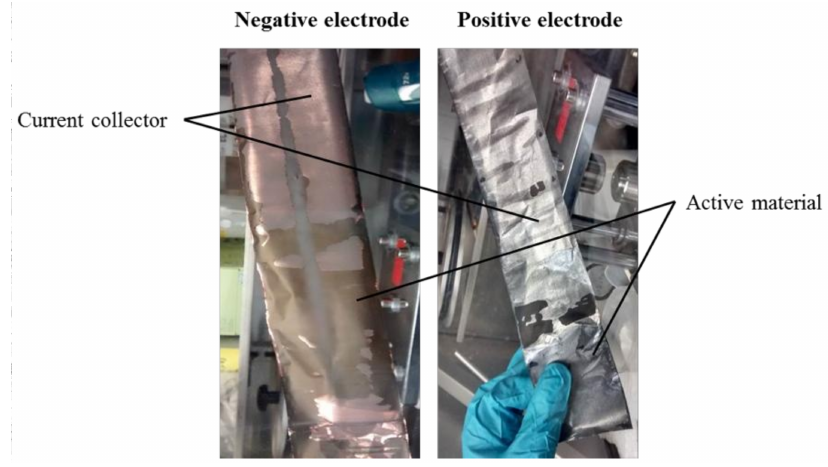
Figure 1. Electrodes removed from a commercially available 18650